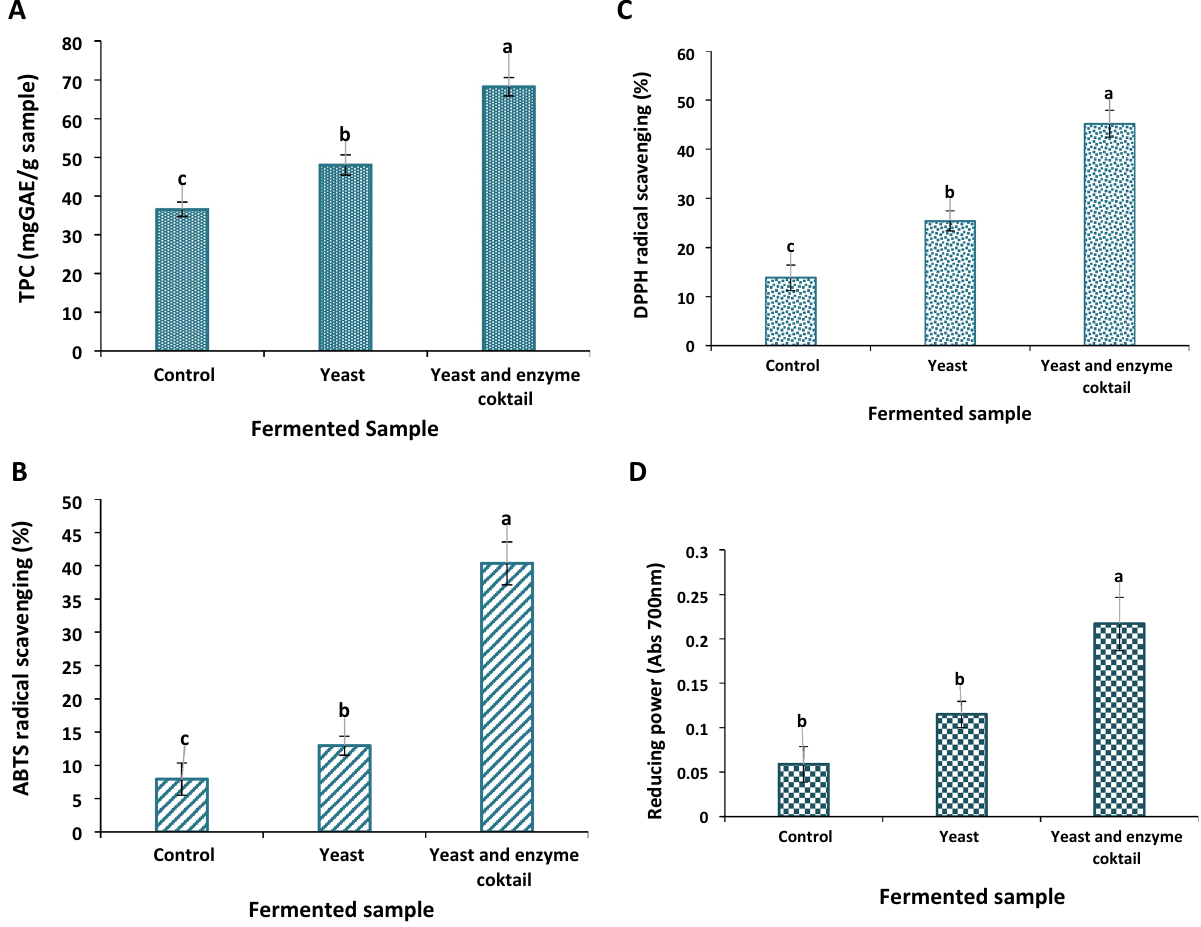
Figure 6. Phenolic content and anti-oxidant activities of the control, yeast added and fermented-enzyme cocktail treated samples. ( A ) Total phenol content. ( B ) Radical scavenging rate by ABTS. ( C ) Radical scavenging rate by DPPH. ( D ) Reducing power. Means with different letters are significantly different (p < 0.05).